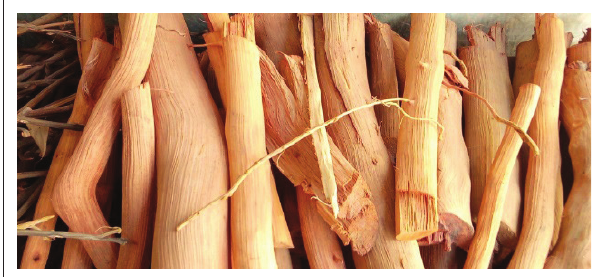
FIGURE 2: Root wood of Calophyllum inophyllum Linn.